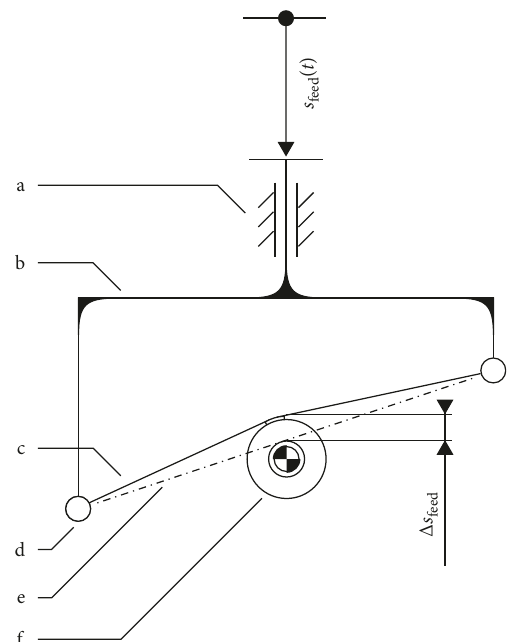
Figure 6: Schematic sketch of the wire deflection test. (a) Uniaxial guidance. (b) Framework for tensioning the wire. (c) Wire deflected. (d) Wire clamping. (e) Wire not deflected. (f) Pulley. Feed travel s feed ( t ). Wire deflection Δ s feed